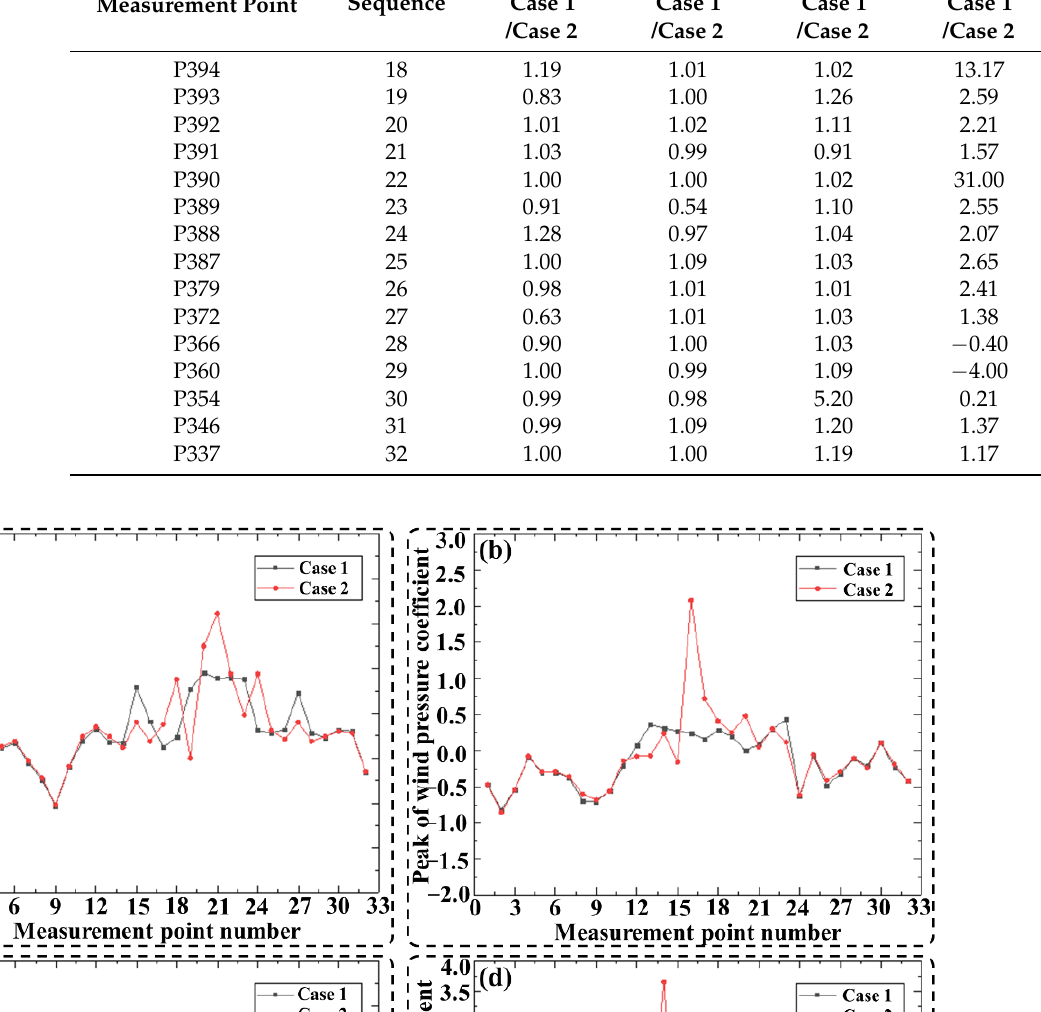
Figure 20. Minimum value of wind pressure coefficient of cross-section under each wind angle: ( a ) 0°; ( b ) 30°; ( c ) 60°; ( d ) 90°.